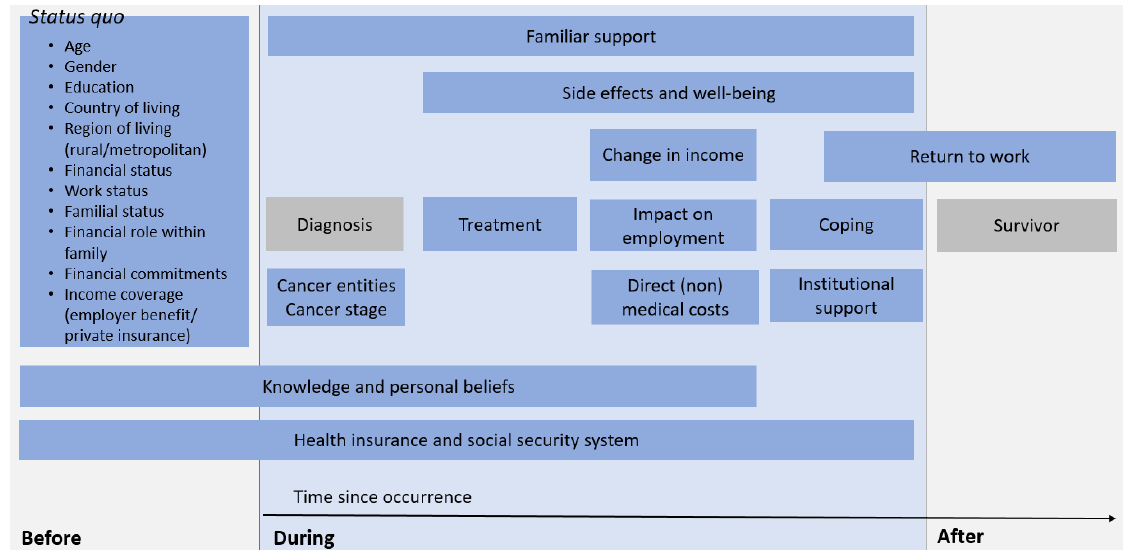
Figure 4. Time-dependent occurrence of identified risk factor (sub)categories for financial distress. Grey coloured risk factors refer to the main stages of the disease pathway (diagnosis and survivorship) accounting for the different origin of the study population experiencing financial toxicity in the included papers.